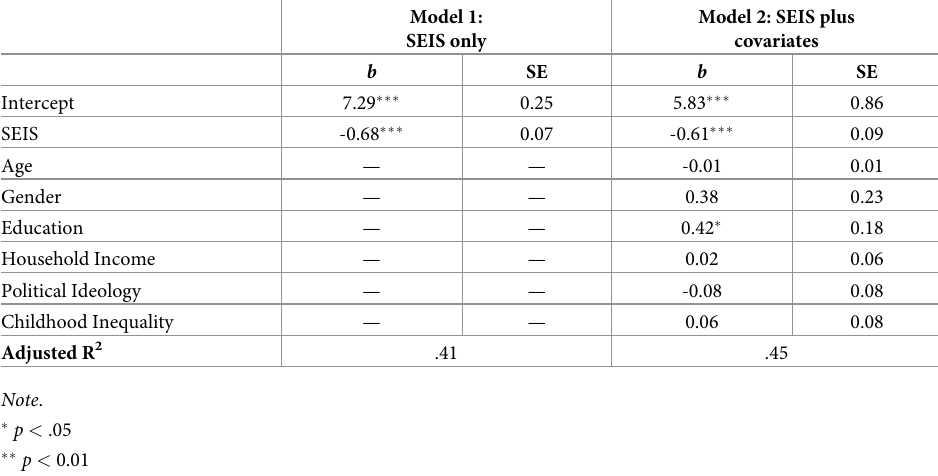
Table 4. Linear regressions of agreement with the content of the petition onto the SEIS scale, controlling for rele- vant covariates.